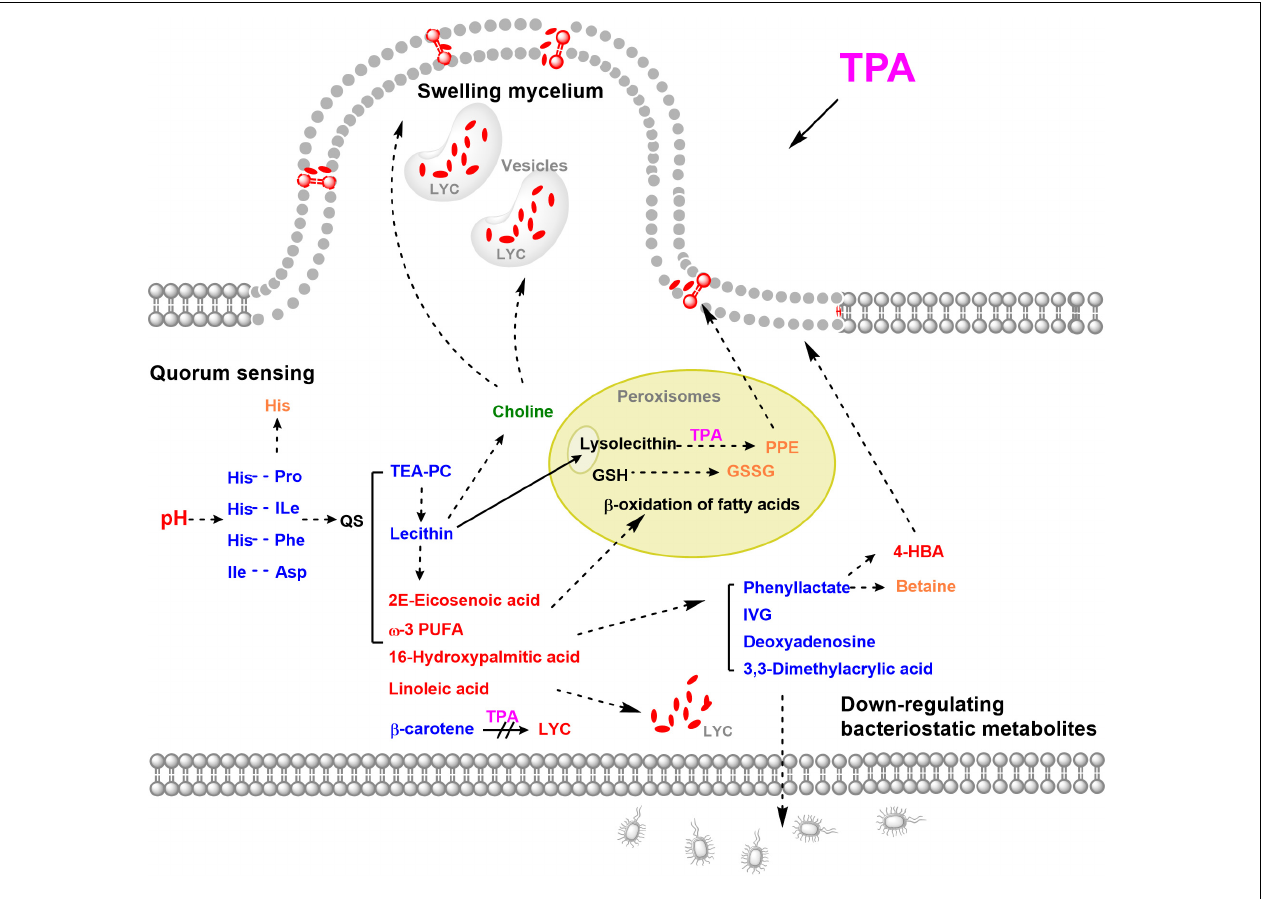
FIGURE 5 | Possible mechanisms of TPA to enhance lycopene in B. trispora. Red, up-regulated significantly differential metabolites; Blue, down-regulated significantly differential metabolites; Orange, up-regulated differential metabolites; Green, down-regulated differential metabolites. Abbreviations: 4-HBA, 4-hydroxybenzoate; GSSG, glutathione disulfide; GSH, glutathione; IVG, isovalerylglycine; LYC, lycopene; PPE, 1-palmitoyl-2-hydroxy-sn- glycero-3-phosphoethanolamine; TEA-PC, thioetheramide-PC; TPA, tripropylamine; ω -3 PUFA, 11(Z),14(Z)-eicosadienoic